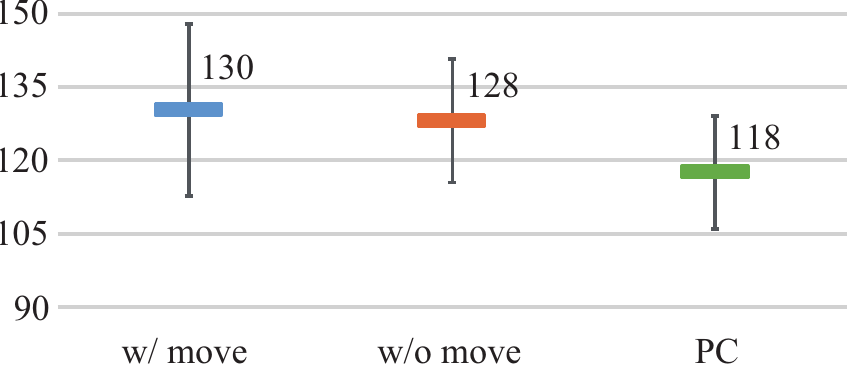
Figure 20. Average of the walking time (zoo)